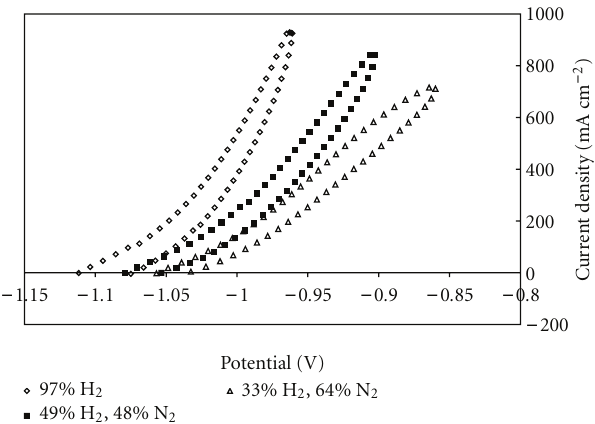
Figure 8: Potential di ff erence between anode and cathode reference electrodes plotted as a function of load